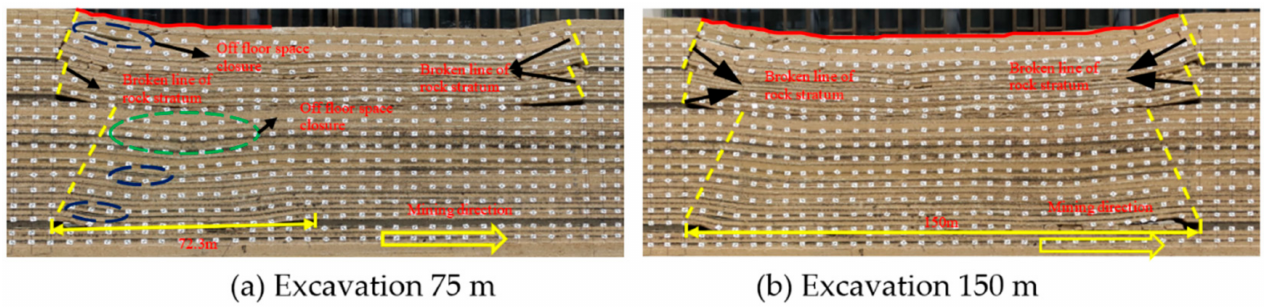
Figure 10. Characteristics of overburden movement and deformation during the mining of the 9# coal seam.